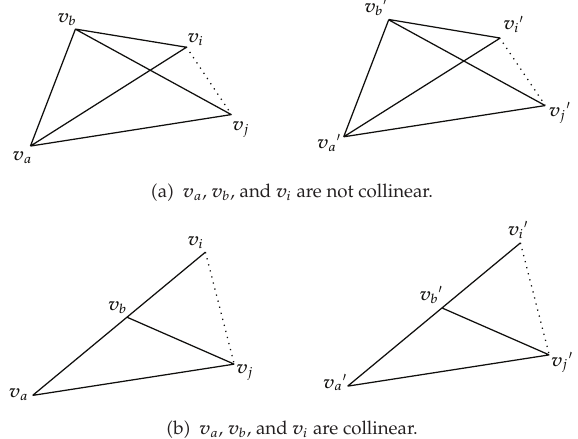
Figure 2: Two pairs of congruent complete